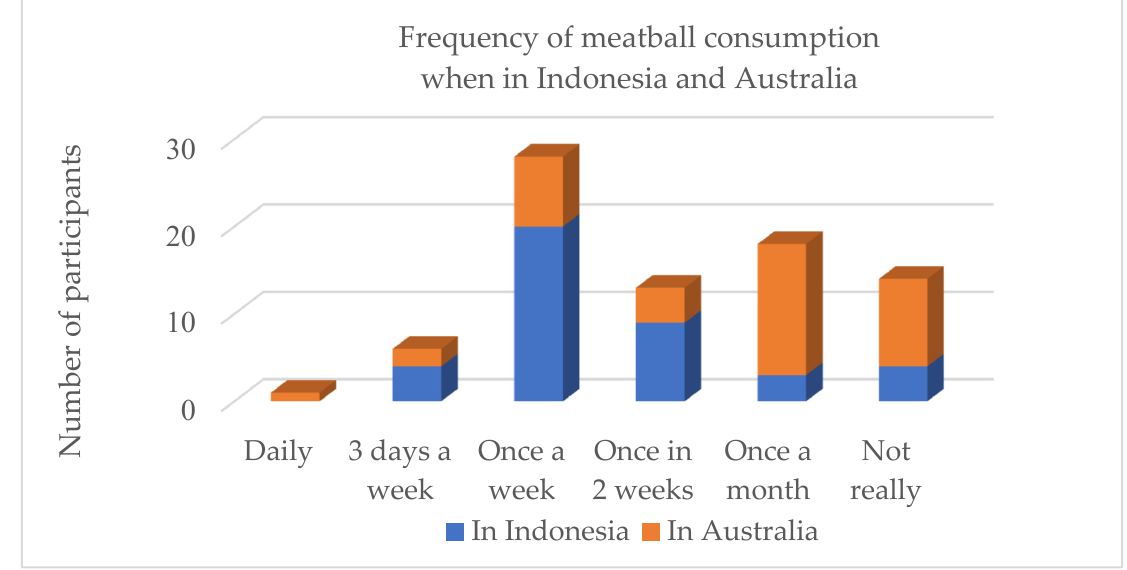
Figure 2. Frequency of meatball consumption both when stay in Indonesia and Australia of our participants, i.e., 40 Indonesians who currently reside in Australia.